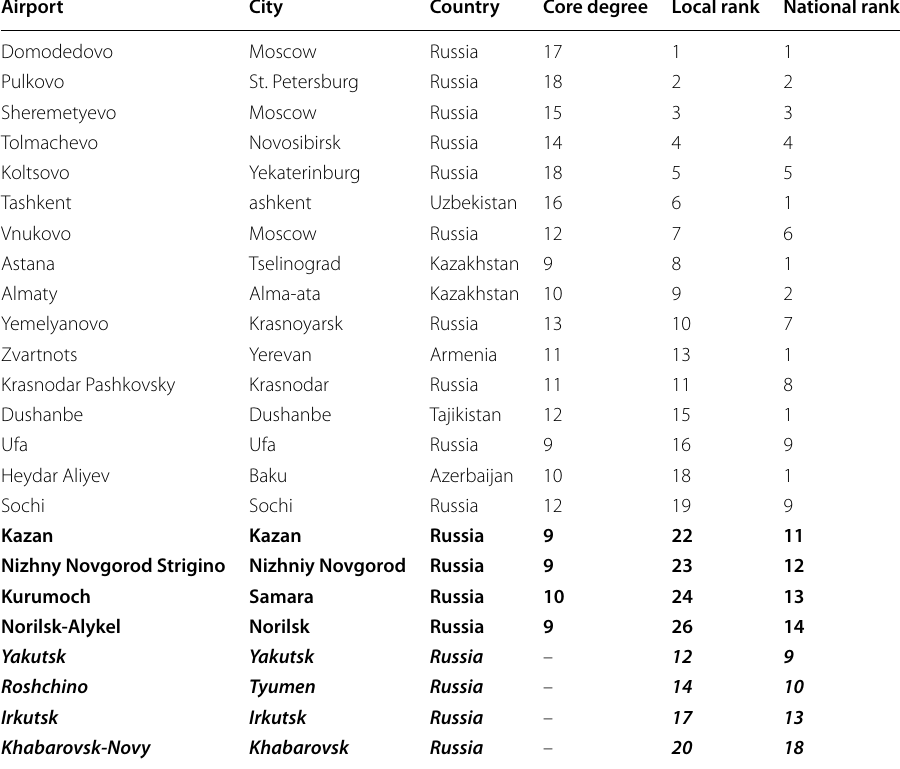
Airports not in the top 16 regional hubs are in bold. The core degree of a node is its number of links in the maximum k-core. Local rank is the rank in the large local component. National rank is the airport rank in its country. Airports in the top 19 regional hubs and not in the k-core are in bolditalic